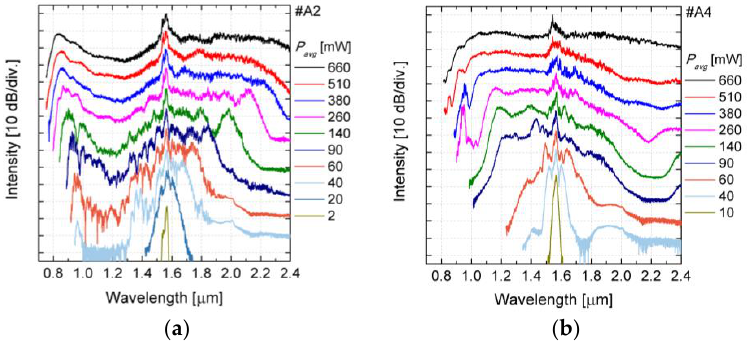
Figure 15. Measured supercontinuum spectra for the fibers ( a ) #A2 and ( b ) #A4 for different average power of the pumping laser. For clarity characteristics are separated vertically by 20 dB.